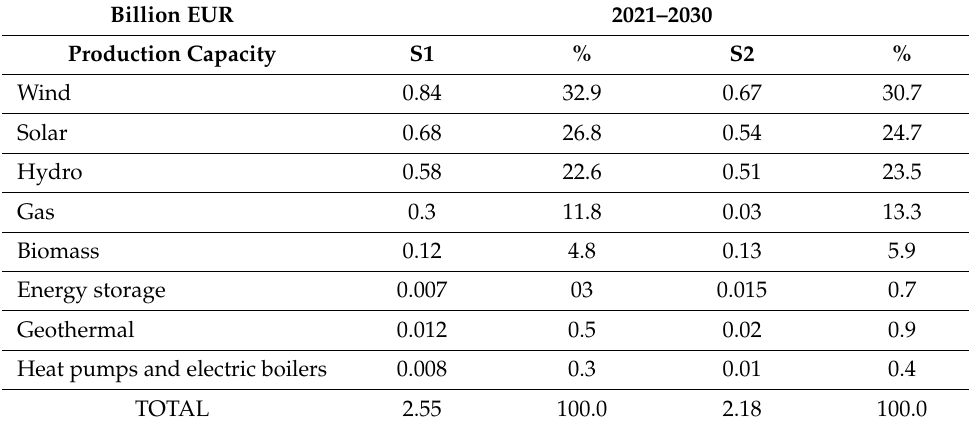
Table 2. Investment in production of electricity according to S1 and S2,